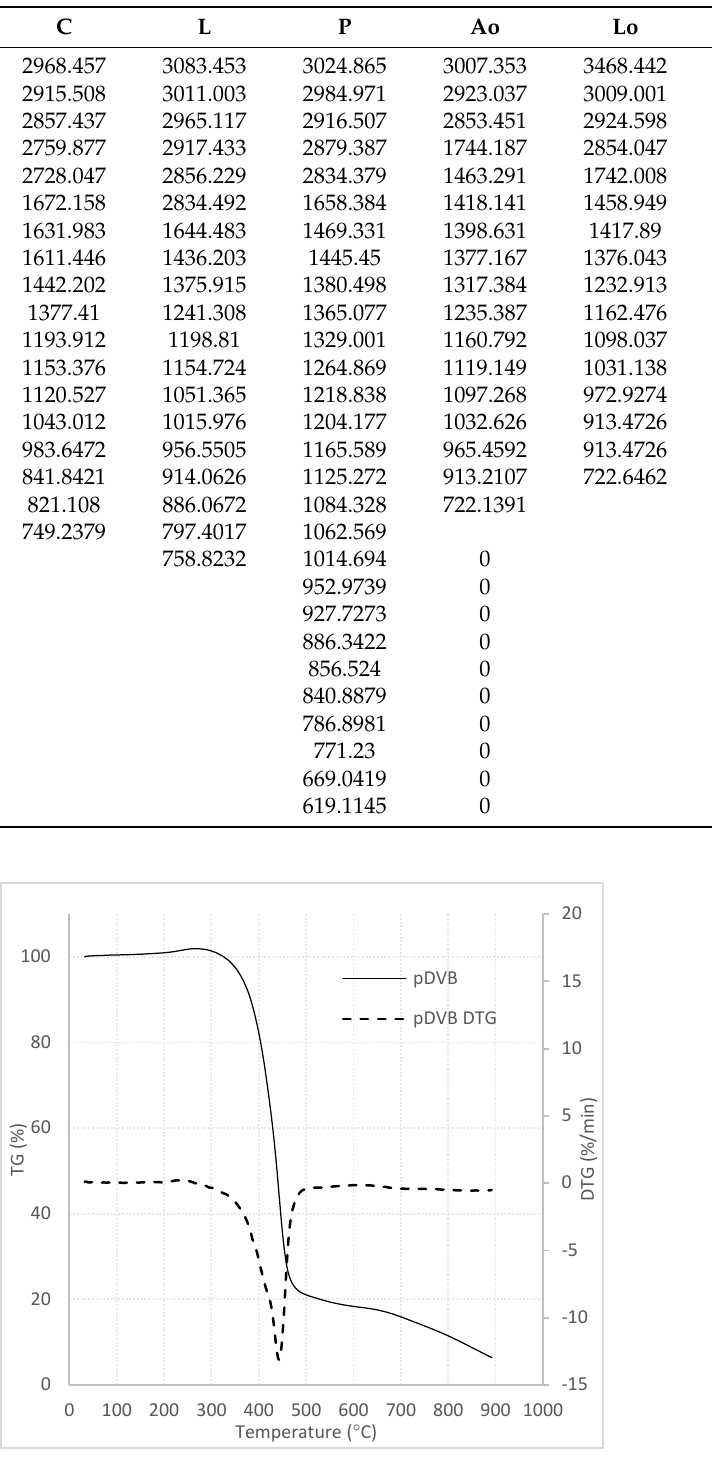
Figure A3. TG/DTG curves of pDVB.